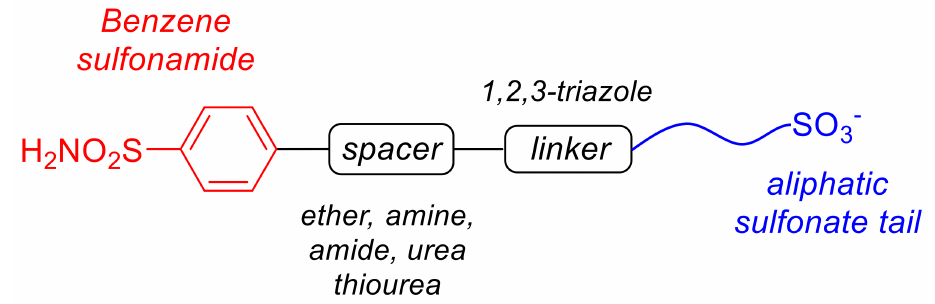
Figure 5. Design of benzenesulfonamides bearing aliphatic sulfonic acid